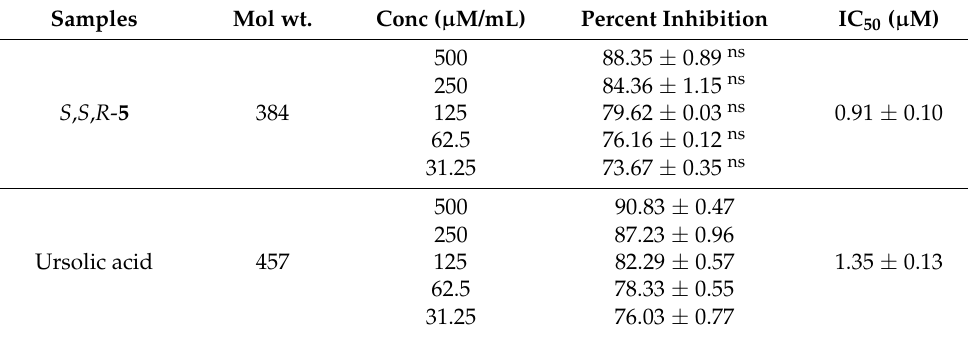
Table 4. Protein tyrosine phosphatase 1B inhibitory results of S , S , R - 5 .